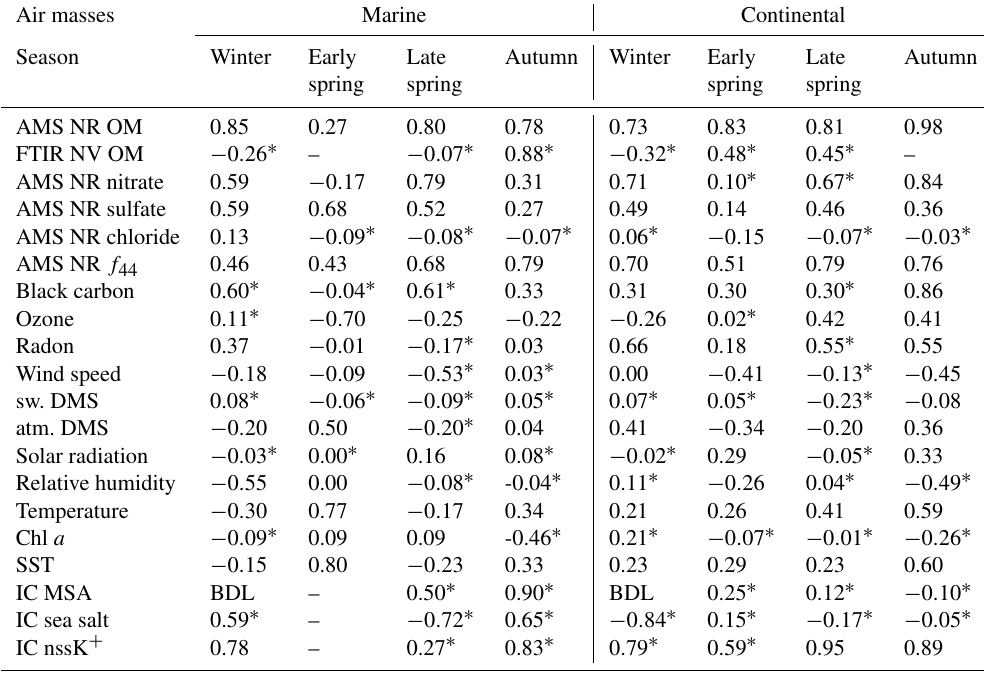
Table 4. Pearson correlation ( R ) coefficient values between AMS NR amine fragments and various tracers for marine periods (columns on the left) and continental periods (columns on the right). The strength of each correlation is given by the magnitude of R : no correlation ( | R | < 0 . 25), weak correlation (0 . 25 ≤ | R | < 0 . 50), moderate correlation (0 . 50 ≤ | R | < 0 . 80), and strong correlation (0 . 80 ≤ | R | ). Correlations that are not statistically significant ( p ≥ 0 . 05) are indicated by “ ∗